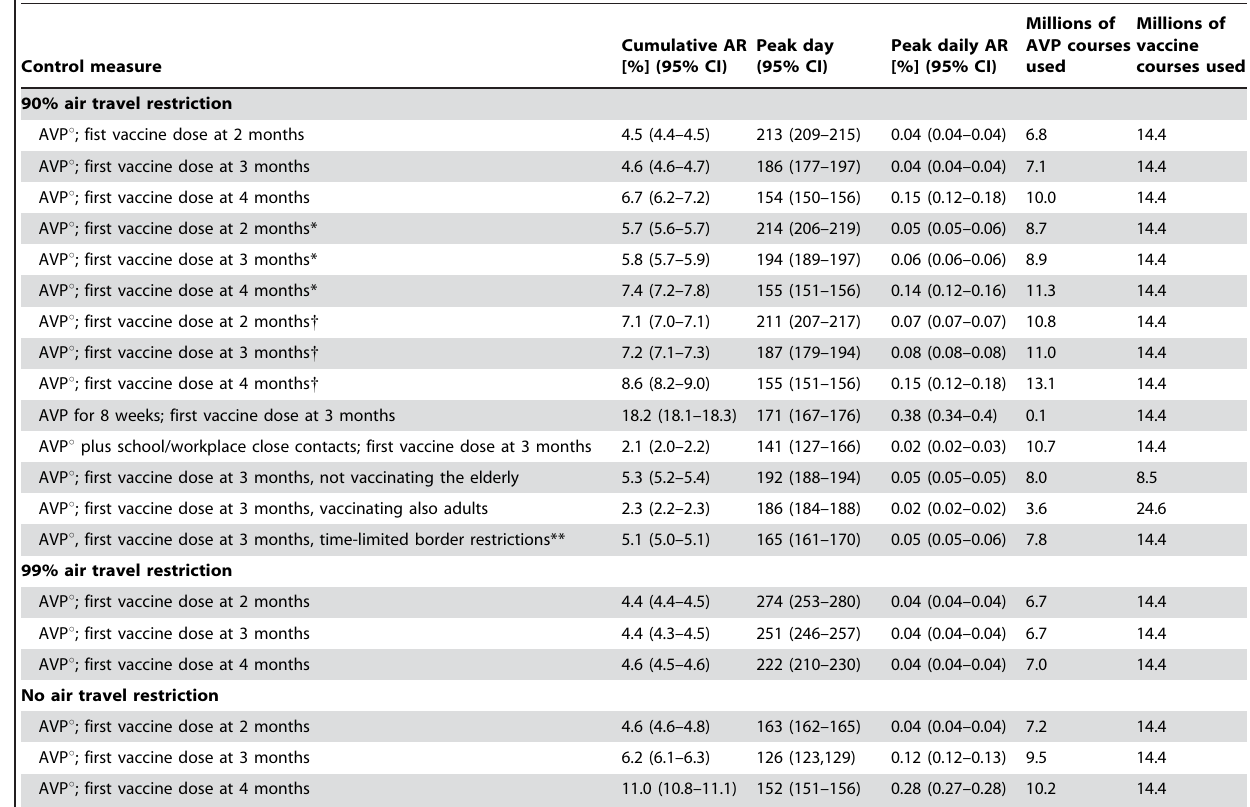
Table 5. Clinical Attack rates and peak day, by combination of control